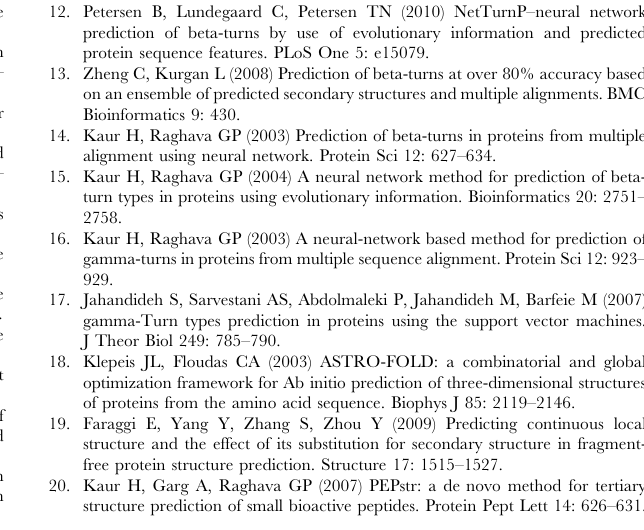
by rows and datasets are represented by columns respectively. Table S4. Distribution of phi angle for 20 amino acids. Table S5. Distribution of psi angle for 20 amino